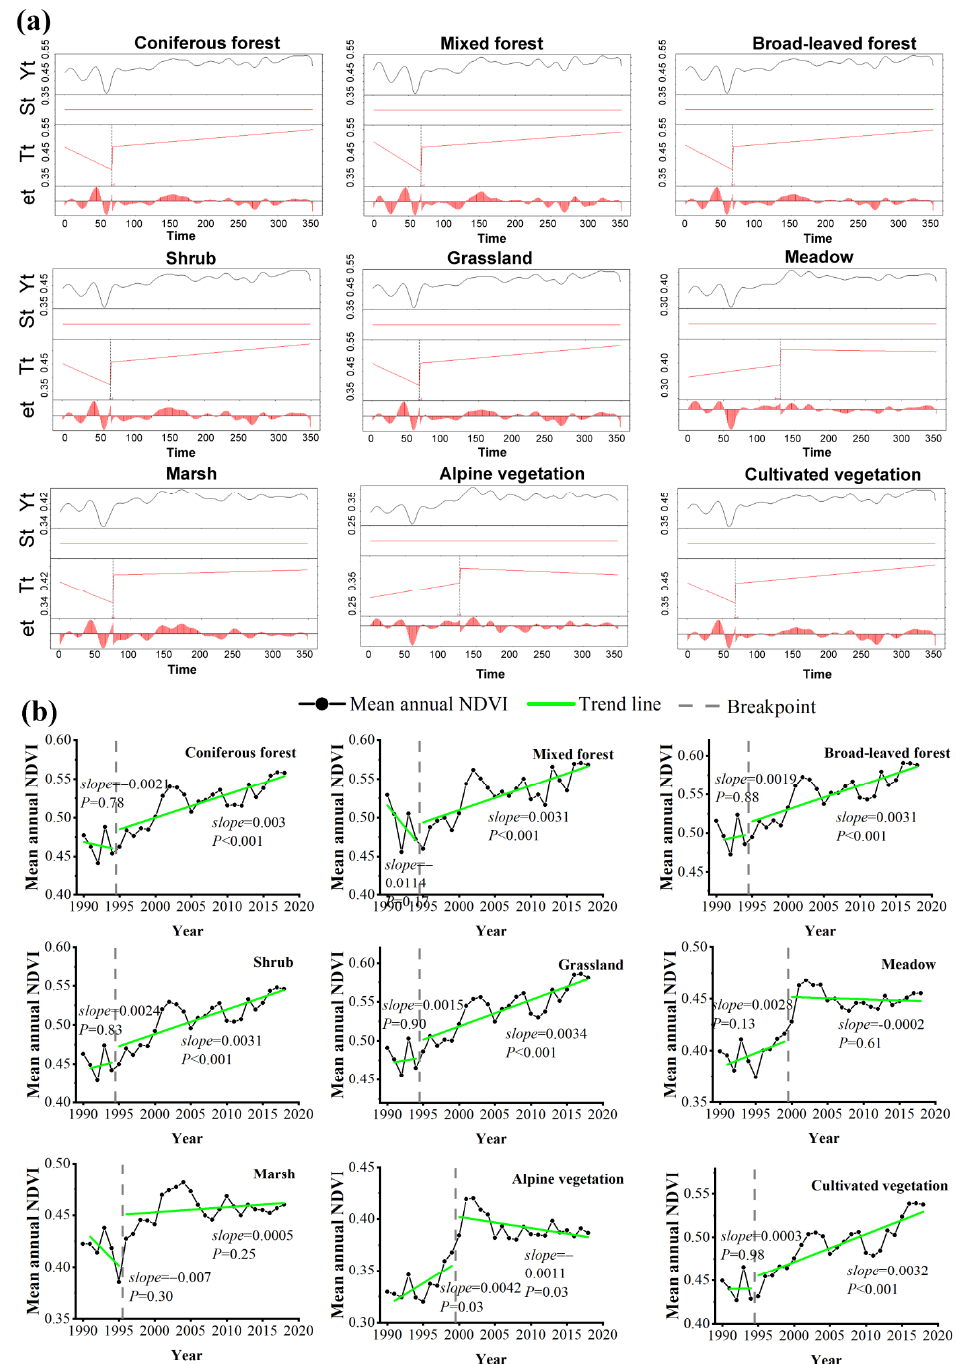
Figure 8. BFAST results for mean NDVI in the different vegetation types of southwest China. ( a ) Abrupt breakpoints detected. Yt: the observed data at time t, St: the period component, Tt: the long-term trend component, et: the remaining component, t: the time of the observation; the X -axis is spaced in months, e.g., 1 for January 1990 and 348 for December 2018. ( b ) Abrupt change in trends.